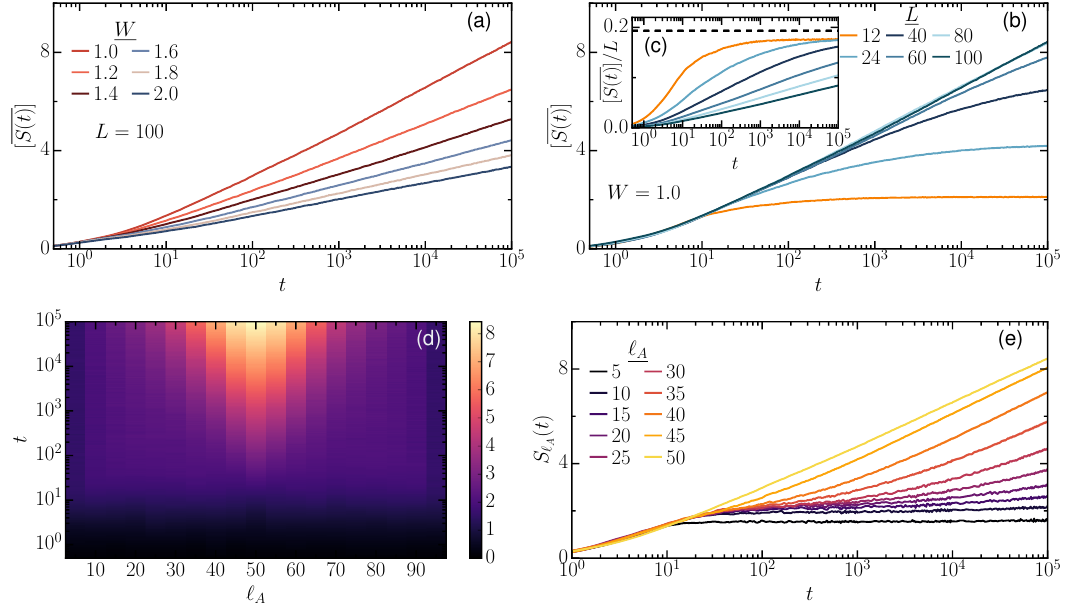
Figure 2: Upper panels: Logarithmic entanglement growth starting from random product states. (a) As a function of disorder strength W for L = 100, and (b) as a function of system size L for W = 1.0. (c) Inset showing the saturation of the averaged entanglement entropy density for the smaller system sizes and diverging exponentially with increasing system size. The dashed line in (c) refers to the en- / L ≈ 0.193 tanglement entropy density averaged over all possible product states, ¯ S (see Eq. (2) in Ref. [ 50 ] ). Lower panels: Entanglement profile. (d) Entanglement entropy (in colorbar) as a function of the cut (cid:96) ; for L = 100, and W = 1.0. (e) A Entanglement entropy growth for the first half of the cuts corresponding to